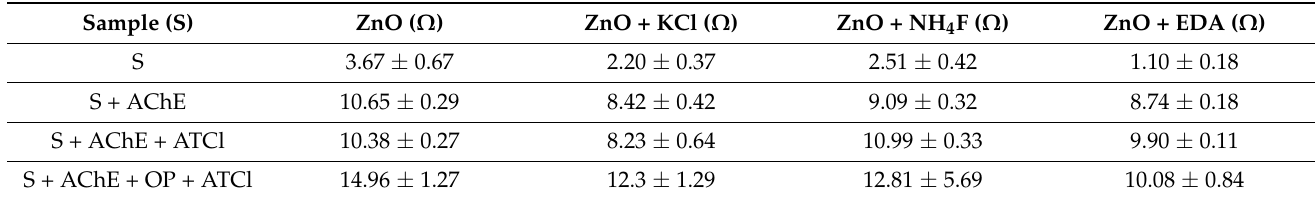
Table 2. Rct values obtained from EIS measurements for ZnO samples on carbon cloth.